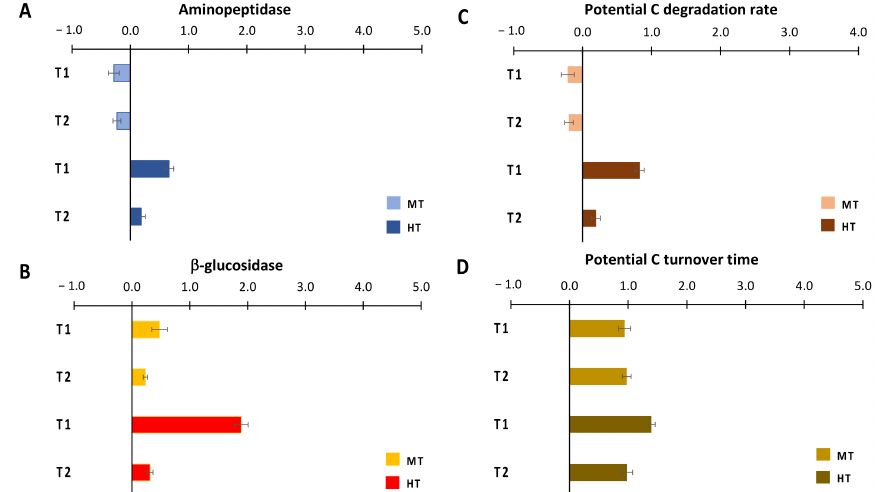
Figure 5. Size effects of temperature anomalies generated by the simulated heat wave on extracellular enzymatic ( A ) aminopeptidase and ( B ) β -glucosidase activities, on ( C ) C degradation rates and ( D ) C potential turnover time. MT = medium temperature anomaly; HT = high temperature anomaly. T 0 = before PPW injection; T 1 = after 3 weeks from PPW injection; T 2 = after 11 weeks from PPW